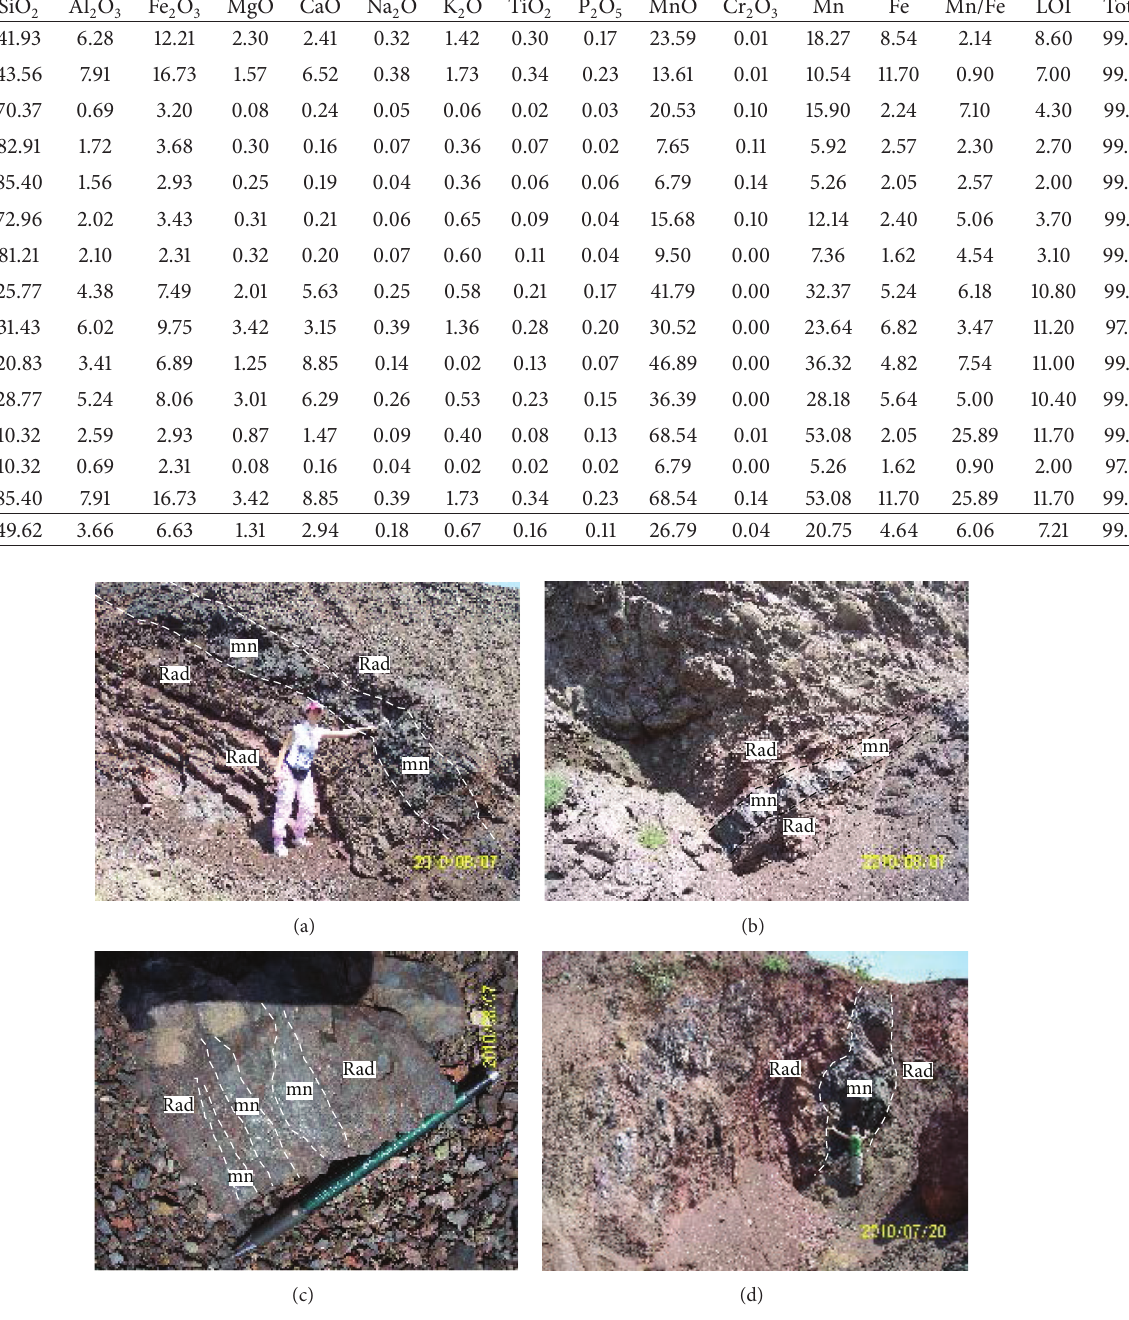
Major oxide, trace, and REE geochemistry are very useful for understanding the formation conditions of ore